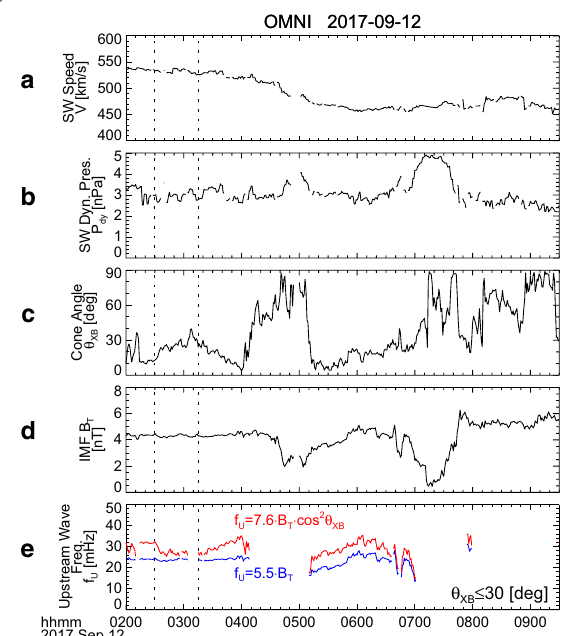
Fig. 3 OMNI data of a the solar wind speed, b the solar wind dynamic pressure, c the cone angle ( θ XB ), and d the magnitude of the interplanetary magnetic field ( B T ) at the Earth’s bow shock nose, as well as e estimated frequency of upstream waves ( f U ) for 02:00–09:30 UT on 12 September 2017. f U is estimated from empirical equations by Gul’elmi (1974) (blue curve) and Takahashi et al. (1984) (red curve) only when θ XB 30°. Vertical dotted lines delineate the time interval ≤ of 02:30–03:15 UT when a transverse Pc3–4 wave with the frequency of ~ 20 mHz was observed by Probe